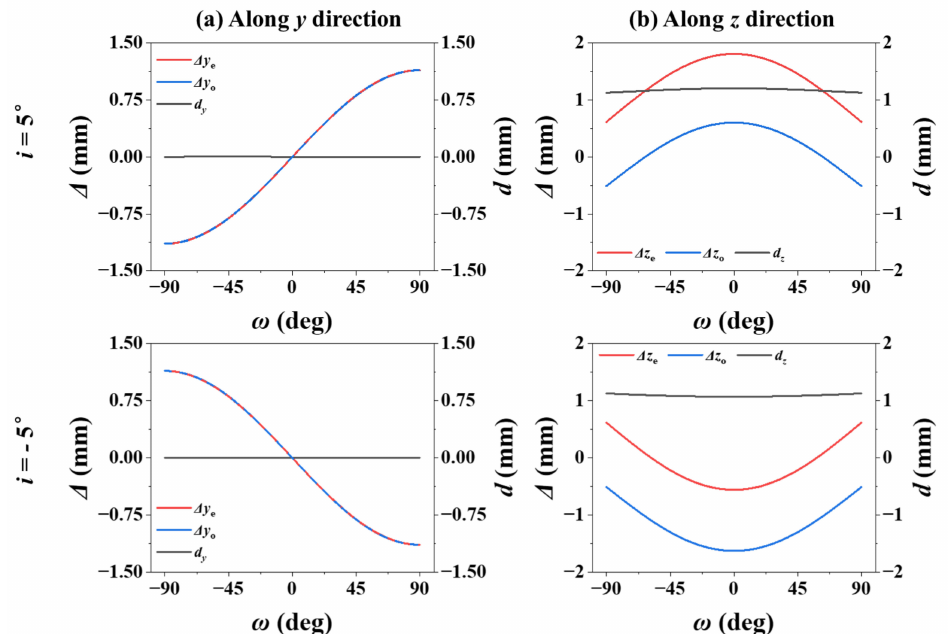
Figure 6. Offset and displacement as function of ω when i = ± 5 ◦ : ( a ) Along y direction; ( b ) Along z